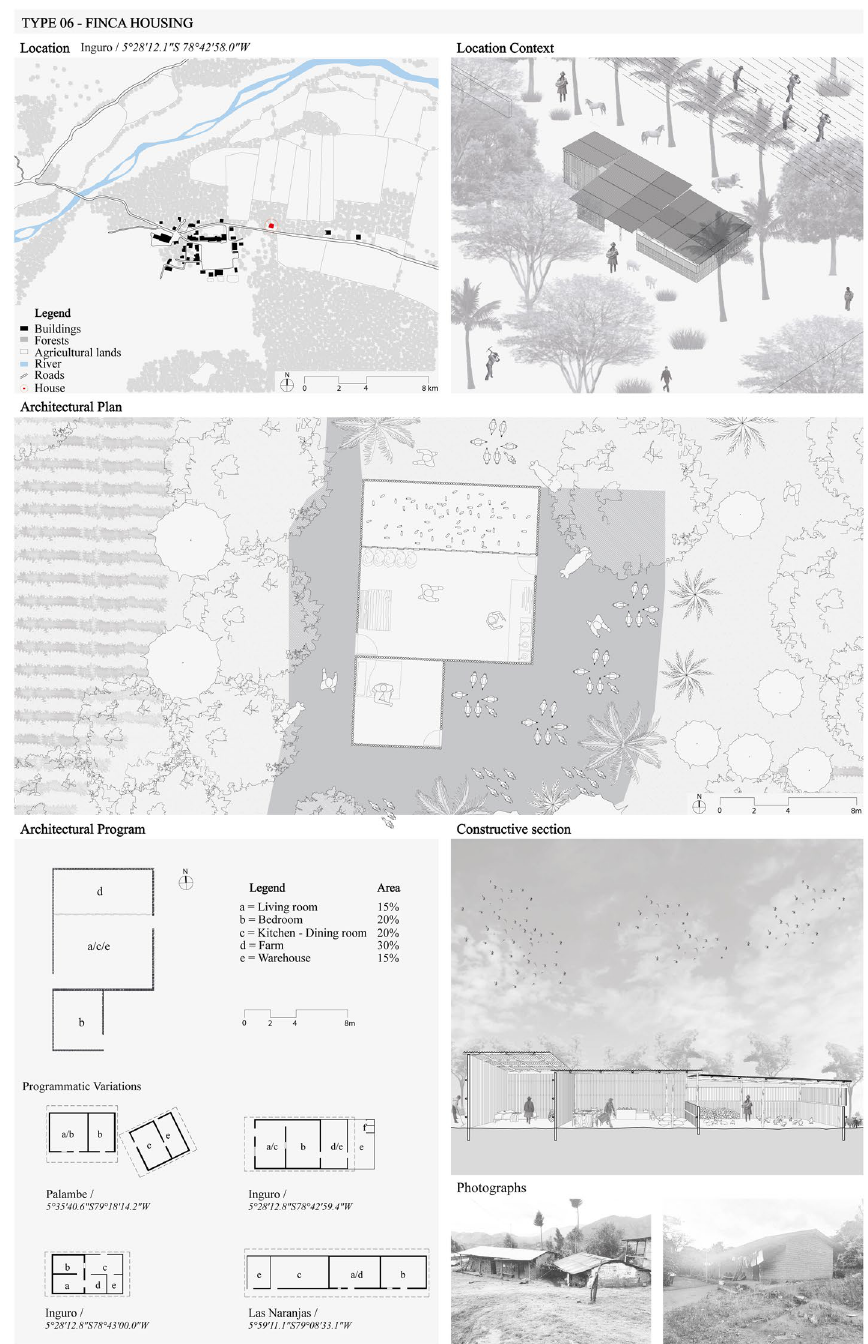
Fig. 7 Architectural characteristics of the “Finca” housing type (Source: the